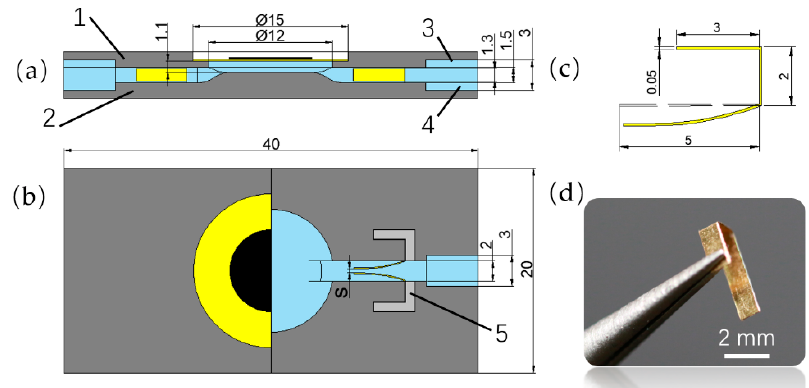
Figure 2. Specific dimensions of the PZT pump: ( a ) the main sectional view of the PZT pump; ( b ) the top view of the PZT pump with a half of its upper part; ( c ) the main dimensions of the compliant structure; ( d ) the fabricated compliant structure; (1) the upper part; (2) the lower part; (3) the groove of the upper part; (4) the groove of the lower part; (5) the groove of the compliant structure.